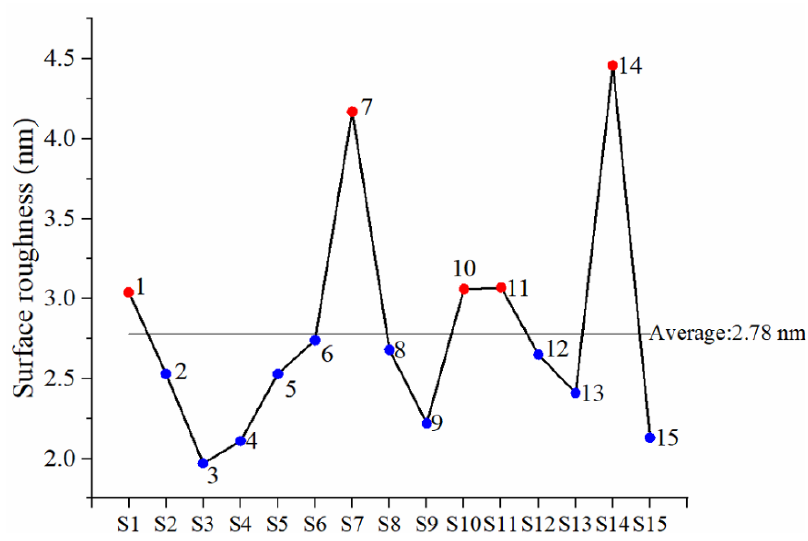
Figure 7. The surface roughness with root-mean-square (RMS) after process completion for the sputtered AlN films in the various pulse parameters as shown in Figure 6 (S1–S15).